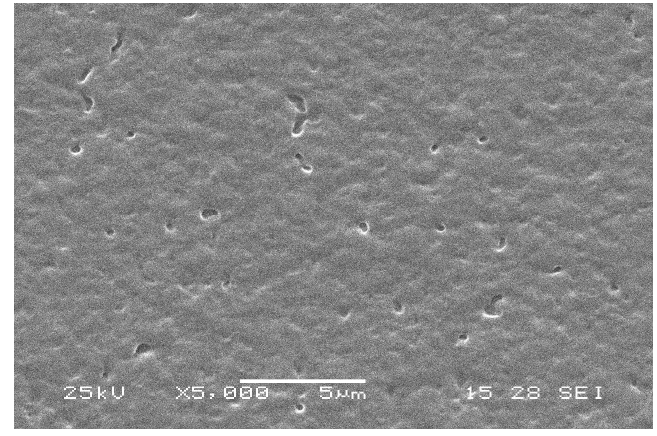
Figure 9. SEM image of the film with SiO 2 –Al 2 O 3 –TiO 2 nanoparticles as the core.